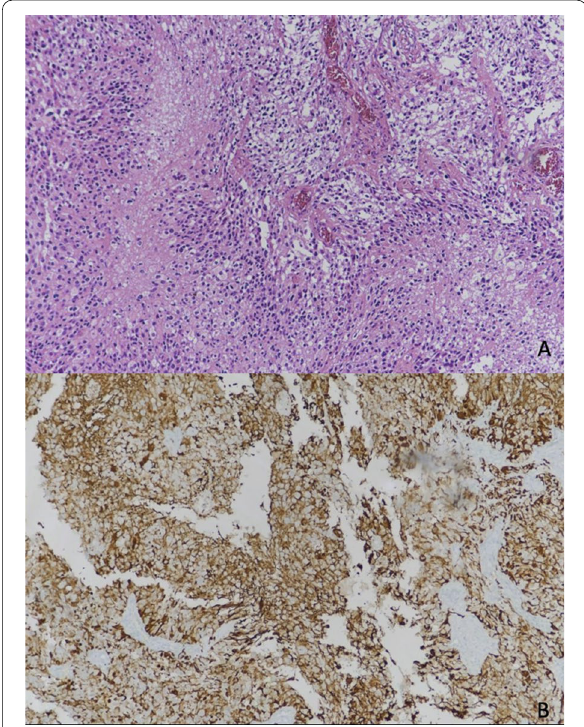
Fig. 2 Cellular tumor with palisading necrosis and vascular endothelial proliferation. A Haematoxylin and eosin (H&E*100). B GFAP positivity